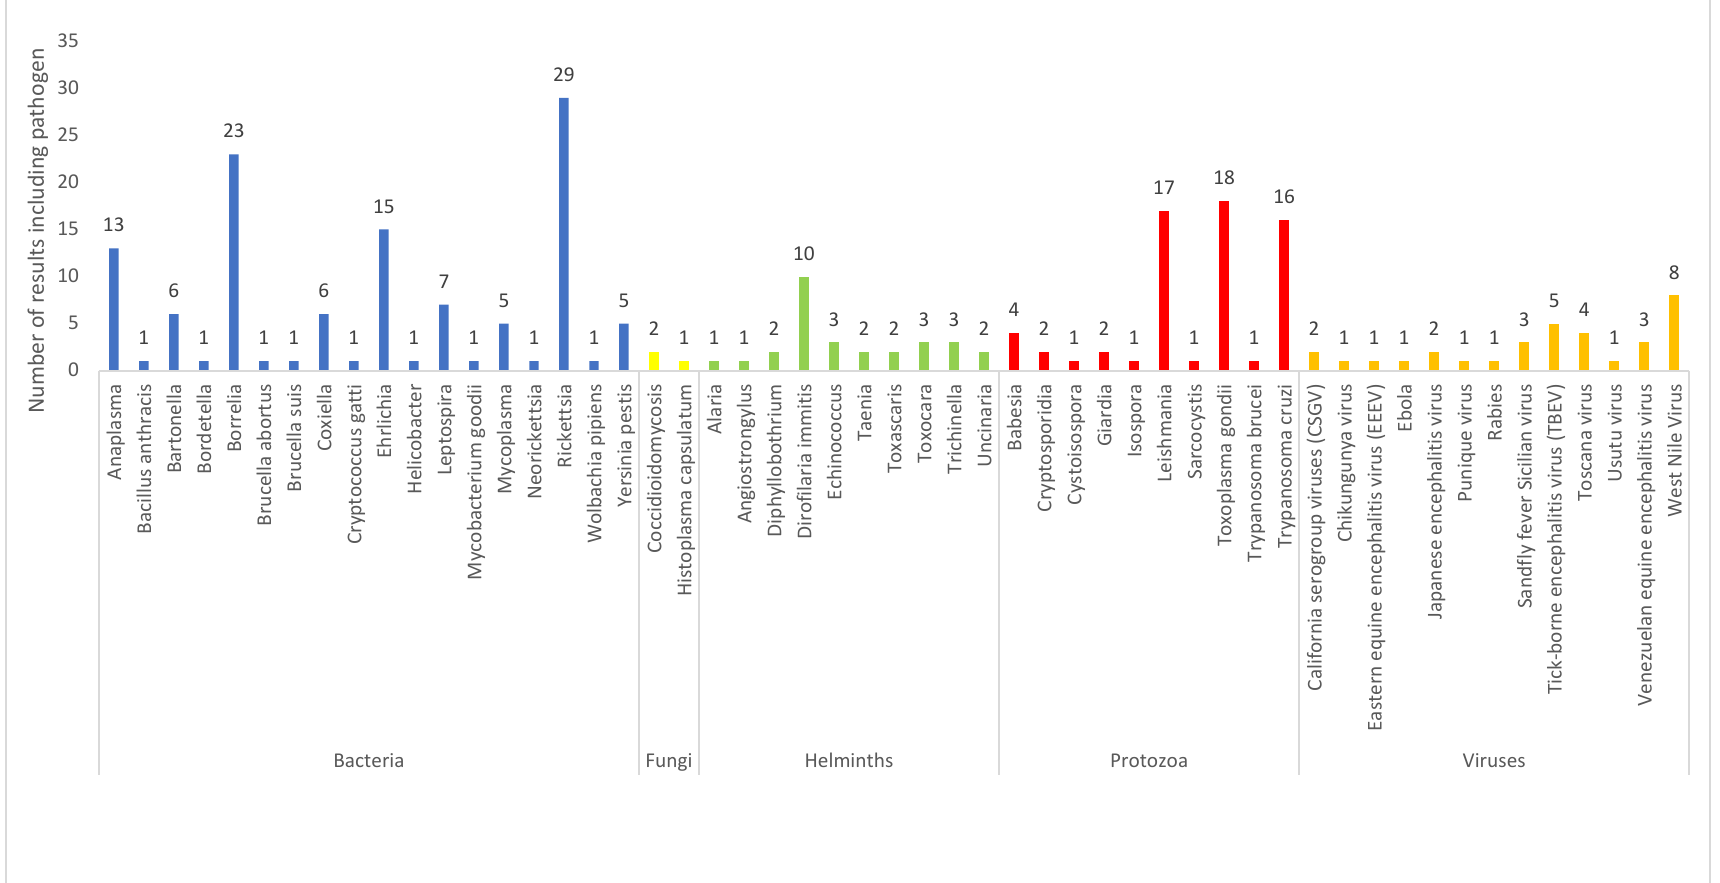
Figure 3. Pathogens identified from the results of the current review ( n = 53).